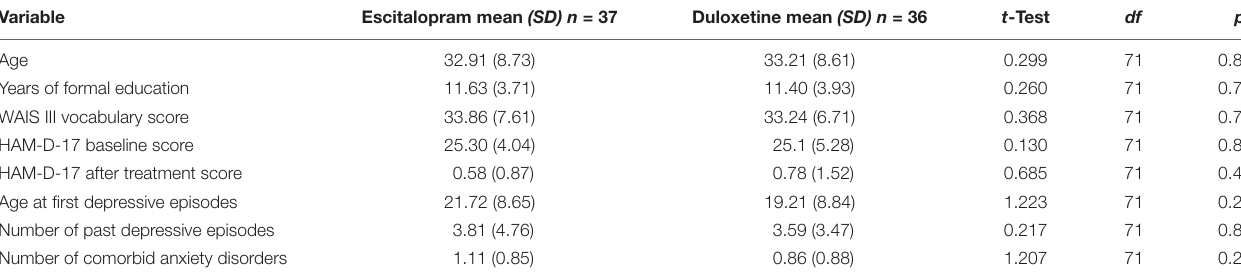
TABLE 1 | T -Test comparison between treatment groups of descriptive and clinical